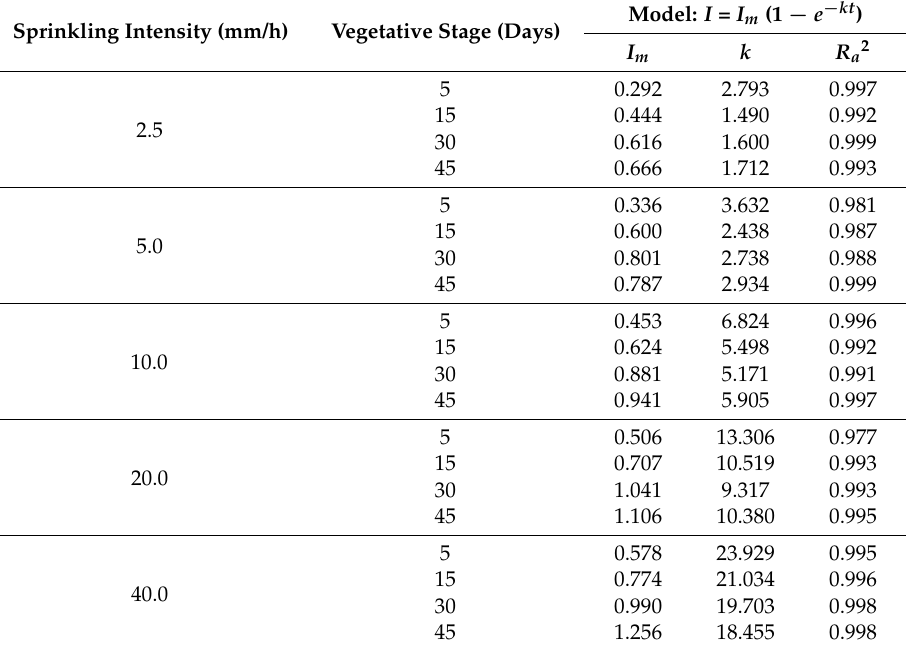
Table 2. Coefficients of the dynamic interception model of alfalfa